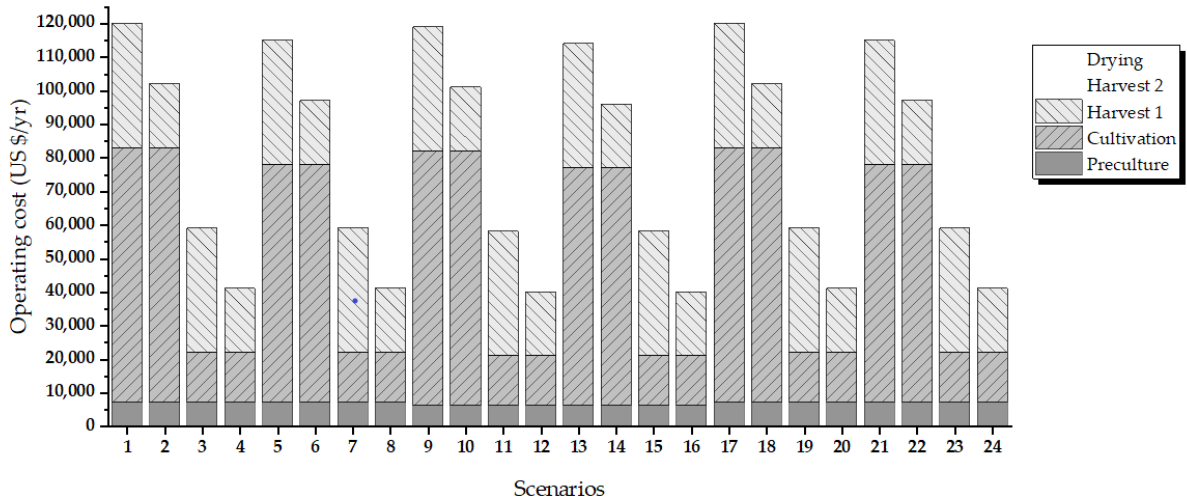
Figure 7. Distribution of the production cost in the harvesting and drying stages of the biomass. All scenarios are fed from the PBR effluent.